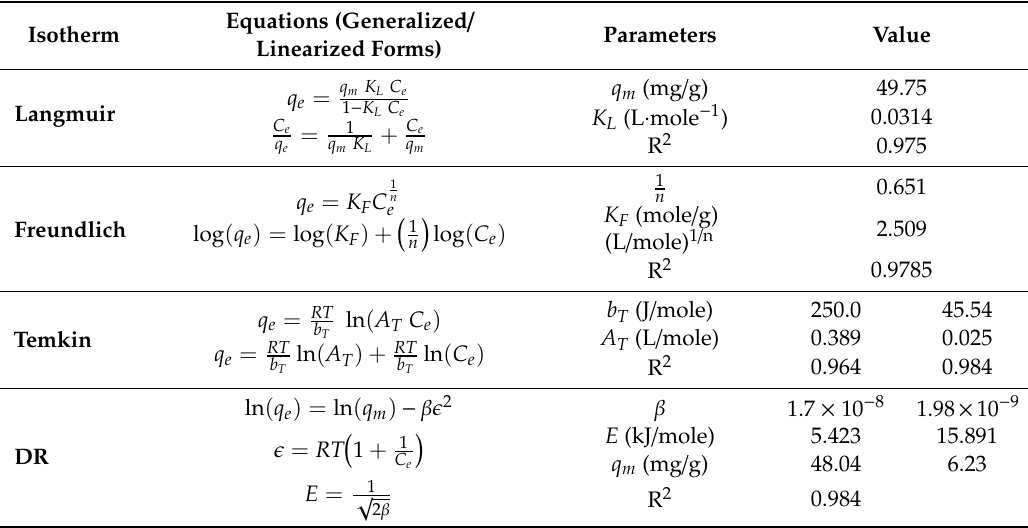
Table 7. General and linearized equation of Langmuir, Freundlich, Temkin and Dubinin-Radushkevich isotherms, beside their parameters for the adsorption of SARA on